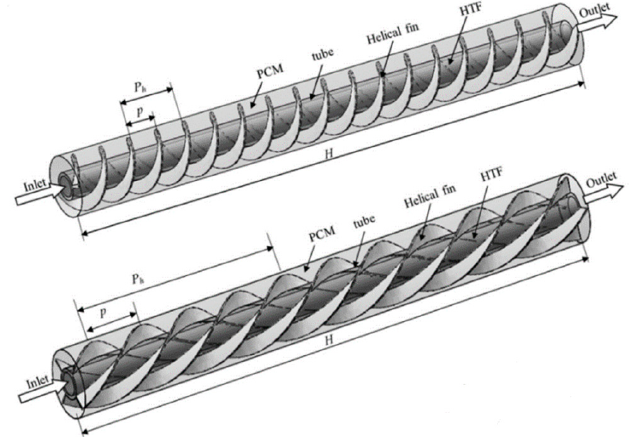
Figure 14. Double helical fins and quadruple helical fins [121]. (Permission to reproduce from Ref. [121]).